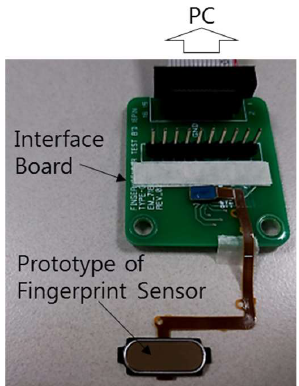
Figure 8. Cross-sectional view of the prototype with the air-wall in the passivation layer.